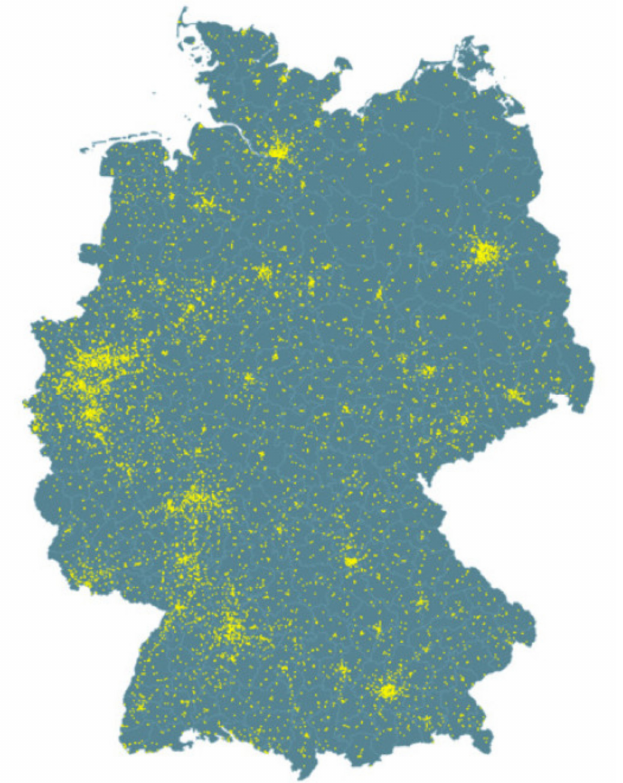
Figure 1. Geospatial distribution of hydrogen fueling stations in Germany by 2050, based on the results from Robinius et al. [25].